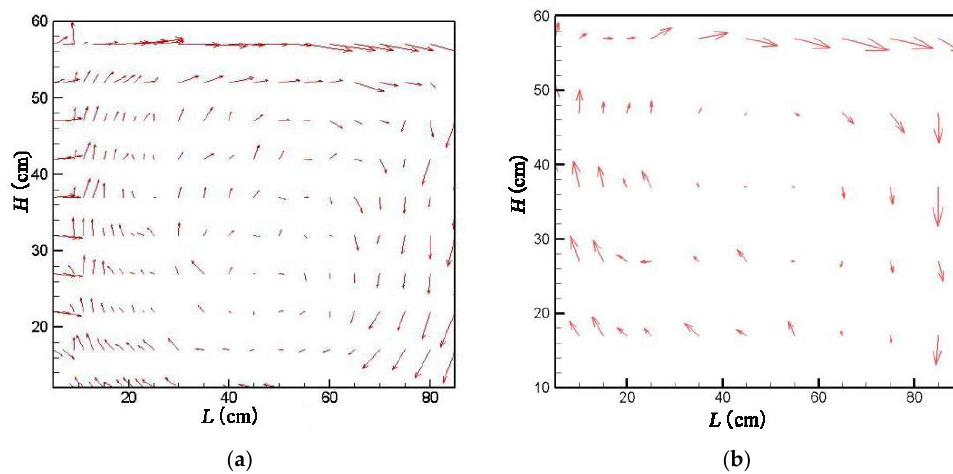
= 20.79 L / s; ( b ) Q = 30.04 L / 2